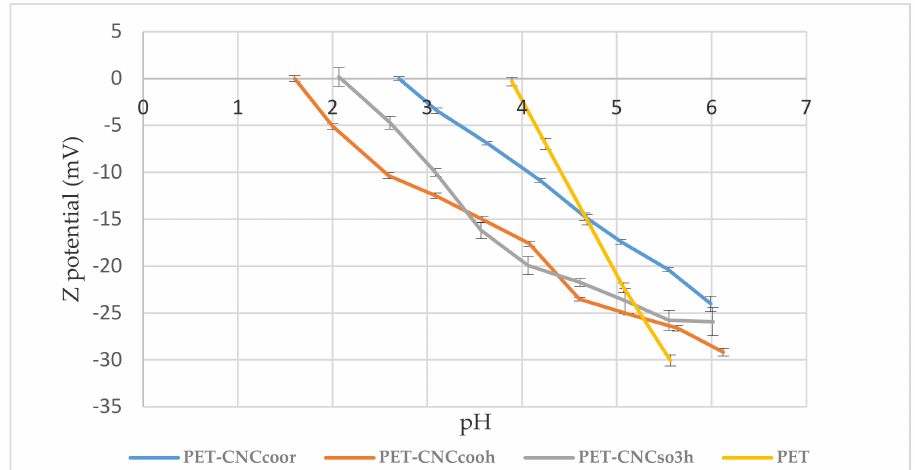
Figure 5. Z potential values versus pH of uncoated and coated PET film with the three types of cellulose CNCs ( n = 3).